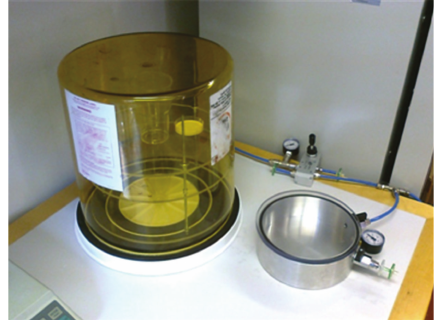
Figure 1: Degassing chambers used to degas the samples.